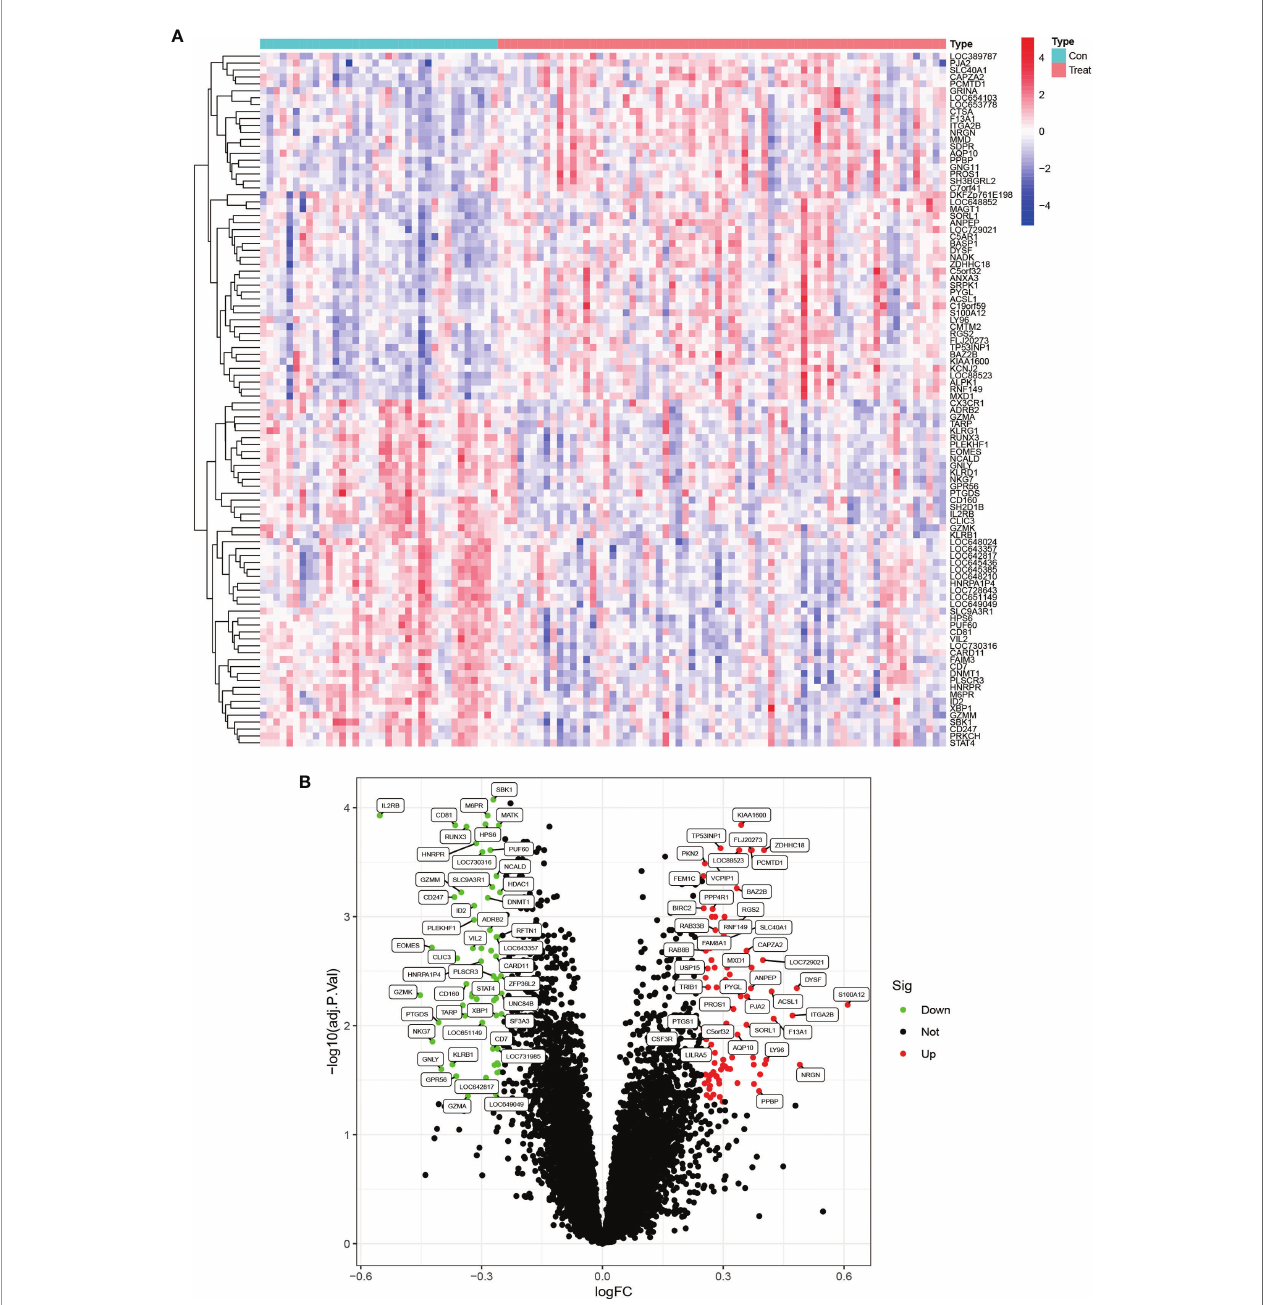
FIGURE 1 | Heat map and volcano plots of differentially expressed genes. (A) shows the heat map of differentially expressed genes, red indicates high expression genes and blue indicates low expression genes. (B) shows the volcano plots of differentially expressed genes, red is for high expression genes and green is for low expression